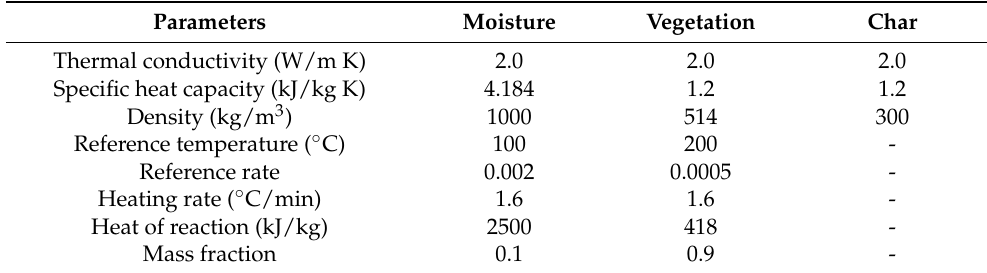
Table 1. Thermal parameters used in Douglas fir tree burning FDS model [18,24,25]. Parameters